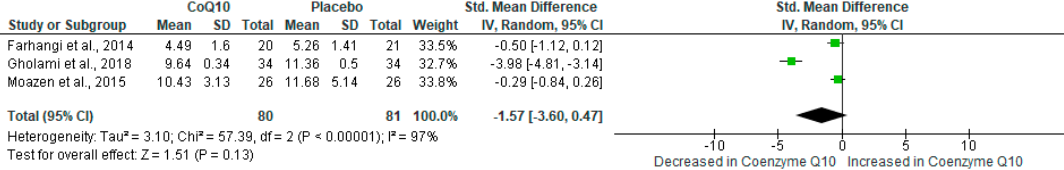
Figure 4. The impact of coenzyme Q 10 (CoQ 10 ) supplementation on malondialdehyde (MDA) levels as a maker of lipid peroxidation in individuals with metabolic syndrome.